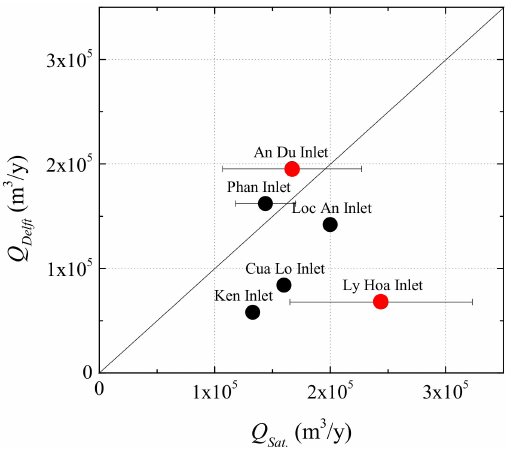
Figure 14. LST rate by the satellite image analysis results versus the Delft3D numerical model results.